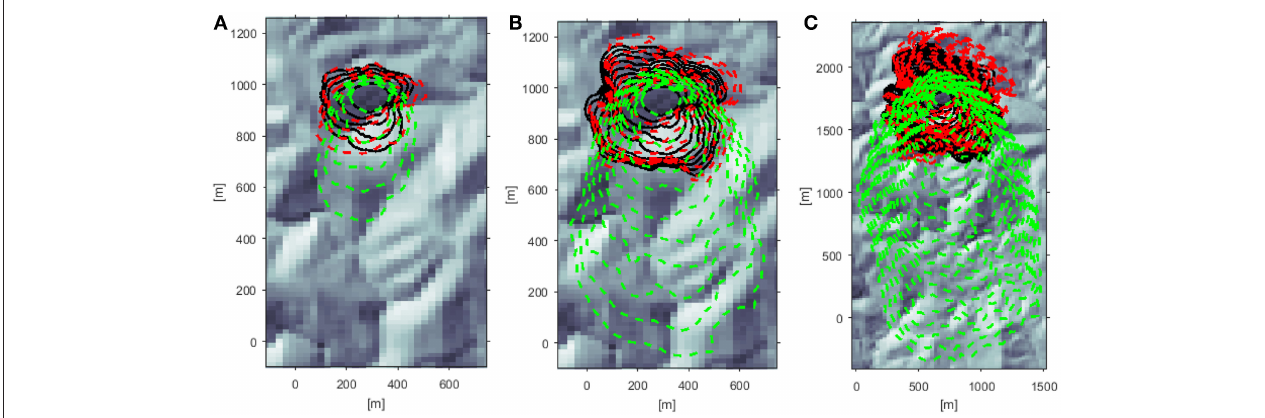
FIGURE 6 | Three different assimilations runs. North direction is toward the top of the image. Black solid lines are observations, dashed green lines are initial run, and dashed red lines are the optimized fronts at the end of the assimilation period. Background image is the hillshade representation of the domain. (A) 5 fronts. (B) 10 fronts. (C) 22 fronts.